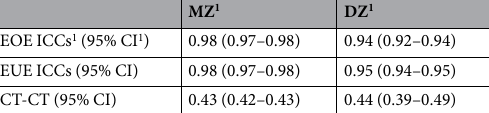
Table 2. Intraclass correlations (ICCs) and cross-twin cross-trait (CT-CT) correlations for EOE and EUE measured at 5 years. 1 MZ: Monozygotic; DZ: Di-zygotic; EOE: Emotional Overeating; ICCs: Intraclass correlations; CI: Confidence intervals; CT-CT: Cross-twin cross-trait.